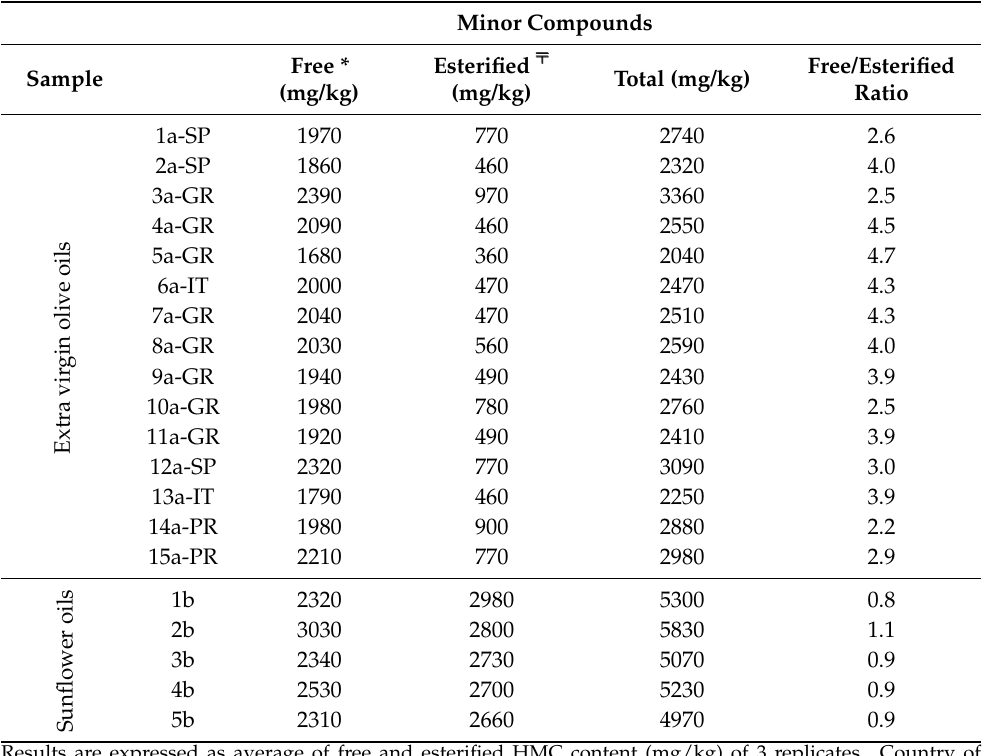
Table 2. Free and esterified HMC content (mg/kg) and ratio in selected pure EVOO and RSO samples. Minor Compounds Free * Sample